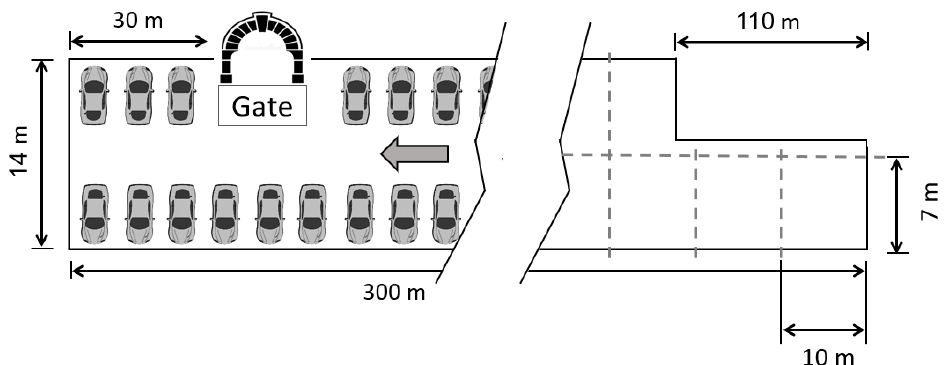
Figure 1. Top view of the parking lot (the case study).